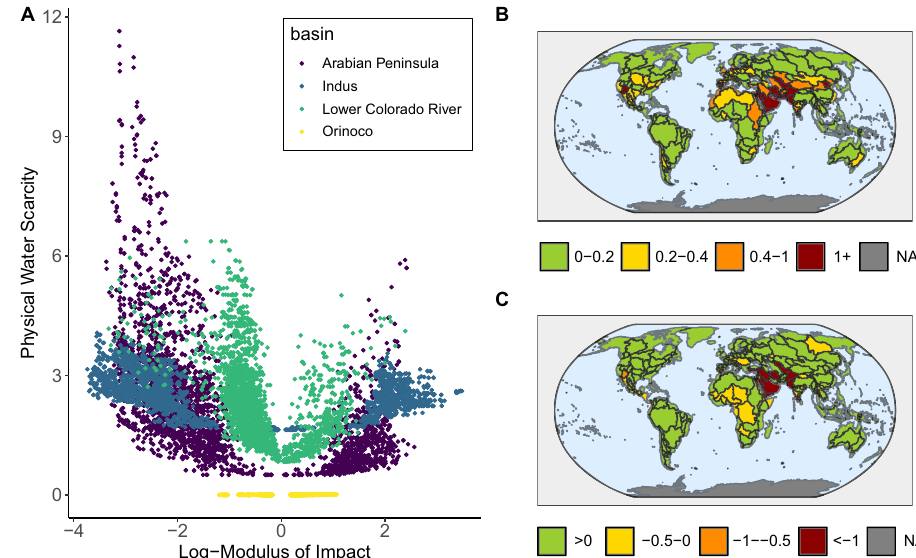
Fig. 1 Economic and physical water scarcity. The scatter plot in panel A shows the two metrics in panels B and C plotted against each other in four basins. Each point represents the maximum absolute value of that metric over time in each scenario. The map in panel B shows WTA in each water basin while the map in panel C shows the log-modulus of economic impact. Both maps plot the maximum absolute value of the metric over time and the median across all scenarios. The correspondence between the two metrics is not perfect. Some water-scarce basins have more capacity to handle water scarcity and thus are not as impacted economically as